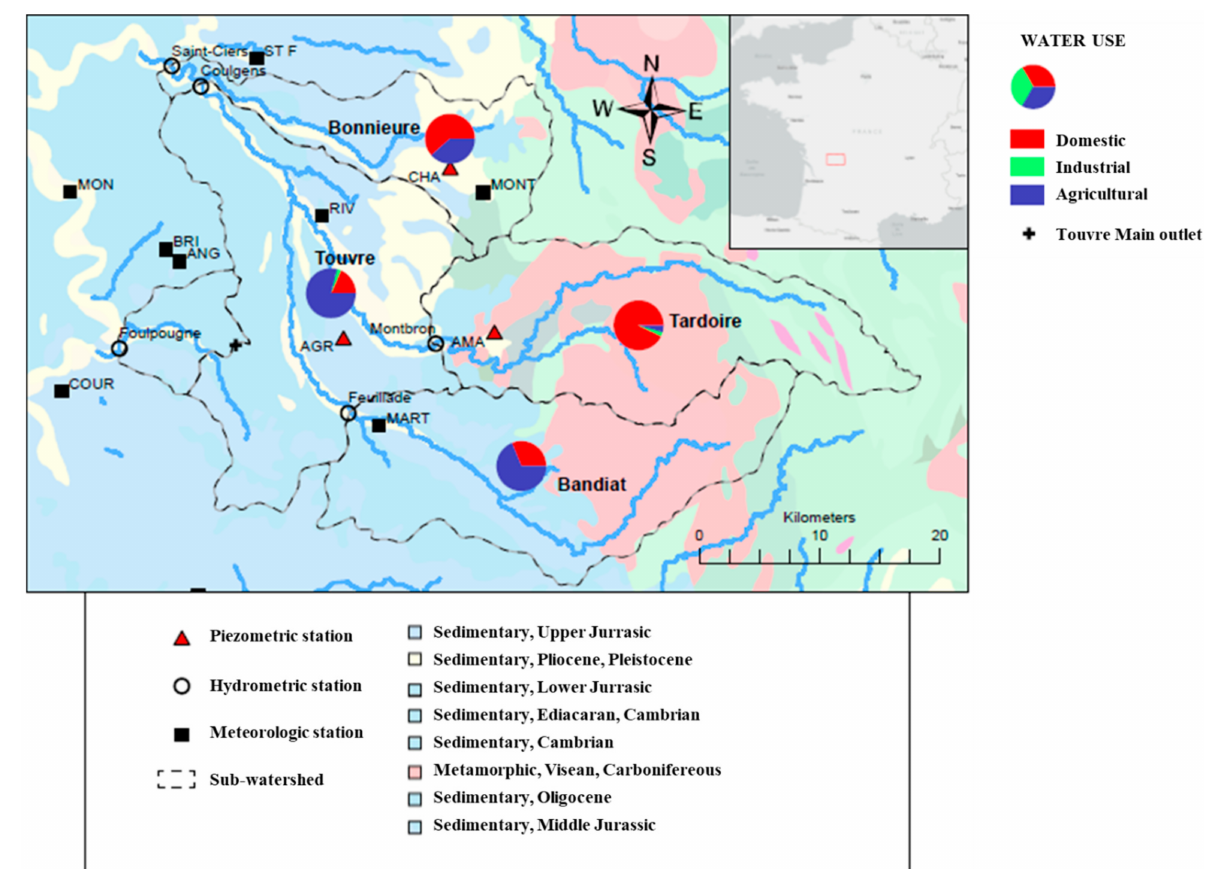
Figure 1. Localisation of the Touvre karst aquifer and of the main hydrological, piezometric and meteorological stations. The percentages of different use of water over the four main sub-catchments (Touvre, Bandiat, Bonnieure and Tardoire) are also mentioned (stations’ acronyms: AGR: